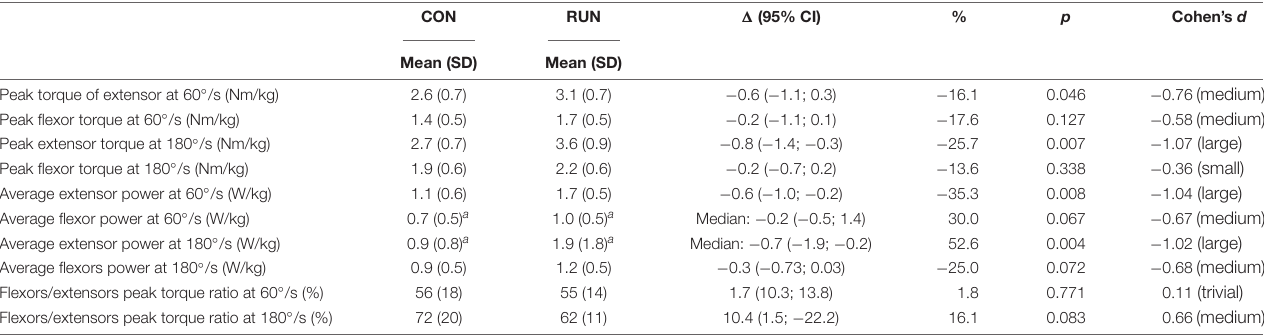
TABLE 3 | Profile of isokinetic trunk variables of older recreationally active adults (CON, n = 15) and older master road runners (RUN, n = 15)